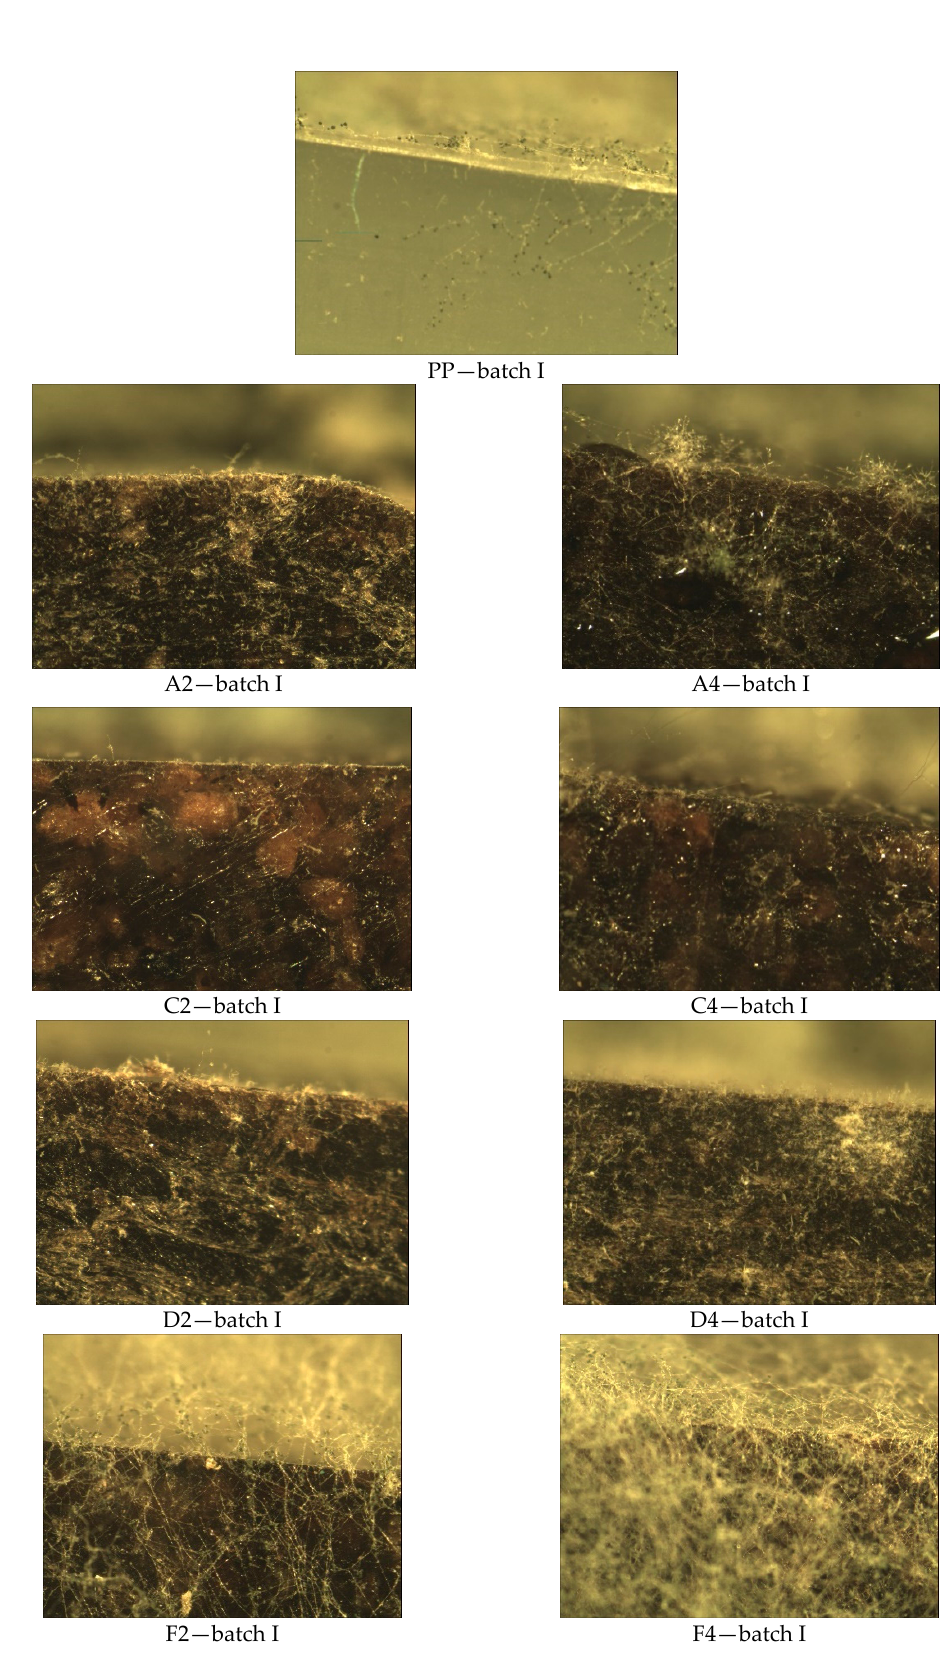
Figure 9. Methods B’—results of microscopic evaluation of batch samples: I. In the case of the walnut filler, significant mycelial growth was observed at both frac- tions and % share in Method A, covering more than 50% of the surface of the examined sample. In contrast, in Methods B and B’, intensive fungal growth was observed for the larger fraction (315–443 µm), covering the entire examined surface. Visual observation of the mycelium growth process on the surface of the tested ma- terials showed that both the environment in which the tests were carried out, the type of filler (hazelnut and walnut flour), the grain fraction, and the percentage of flour in the polymeric composite materials produced had an effect on the result. Visible fungal culture colonies can be observed on samples in Method A, B, and B’ (Figure 3, Figure 4, Figure 5, Figure 6, Figure 7, Figure 8, and Figure 9). The measure of wettability of tested surface is contact angle, also known as wetting angle. It is angle between tested surface and the tangent to the surface of distilled water drop wetting the surface. The value of contact angle lower than 90° determines the degree of wetting of tested surface. A contact angle of 0° theoretically defines the ideally spread- ing liquid over surface and complete wetting. A contact angle of 180° corresponds to the complete non-wettability of the surface. The wettability result is influenced by factors such as: surface heterogeneity under chemical or physical influence, surface roughness, contamination on the surface, and type and size of the measuring drop. Table 6 below shows values of contact angle of tested surfaces.